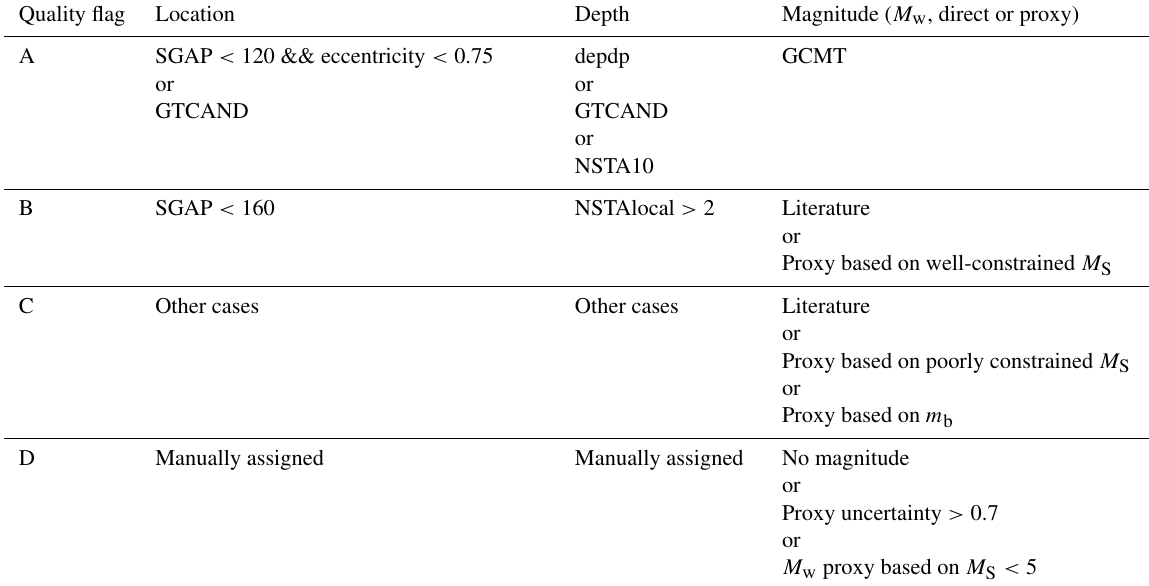
Table 1. Criteria to assign the location quality flags for location, depth and magnitude. SGAP is the secondary azimuthal gap, GTCAND denotes a high confidence location accuracy that makes the event a candidate for the IASPEI Reference Event List (Bondár and McLaughlin, 2009; see also http://www.isc.ac.uk/gtevents, last access: 10 October 2018), depdp is the depth constrained by depth phases (if available), NSTA10 is the number of stations within 10km and NSTA (local) is the number of stations within 150km (Bondár and Storchak, 2011). M S is considered well constrained when it is obtained from more than four stations, within 5.5–7.5, and has uncertainty ≤ 0 . 2. See text for